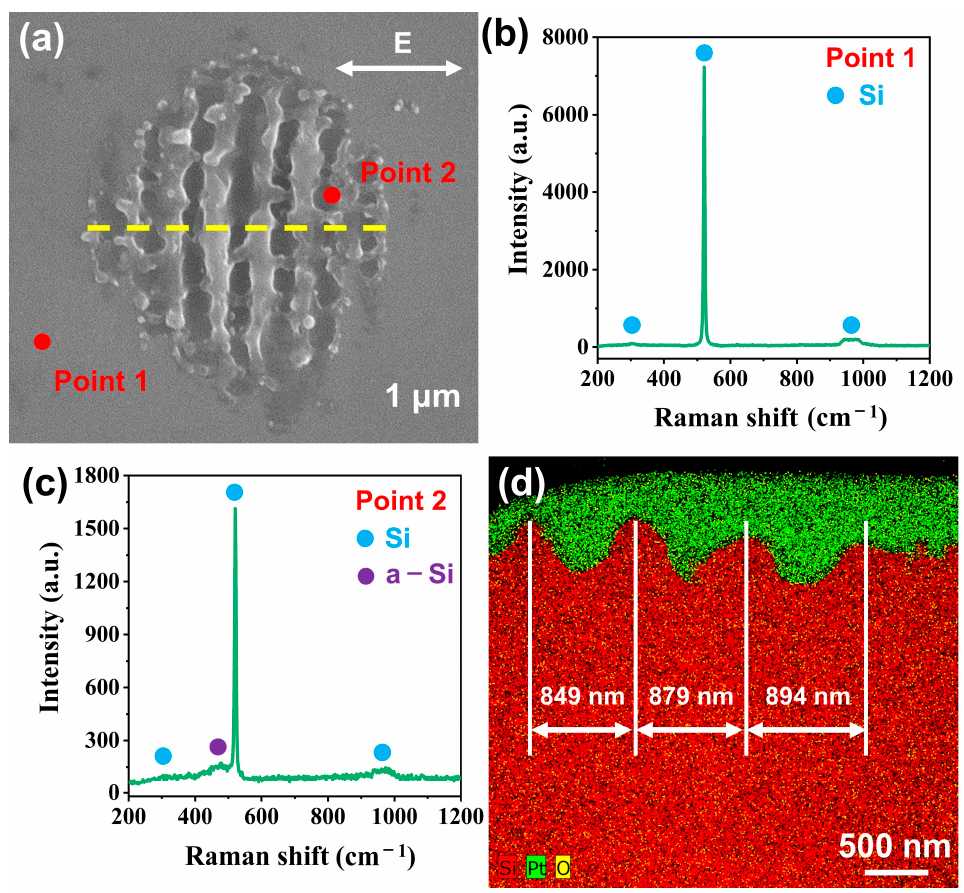
Figure 4. ( a ) The SEM morphology of the LIPSS; Raman spectrum results of ( b ) unirradiated Si, and ( c ) LIPSS; ( d ) EDS map of the FIB lamella extracted from the yellow dashed line in ( a ).